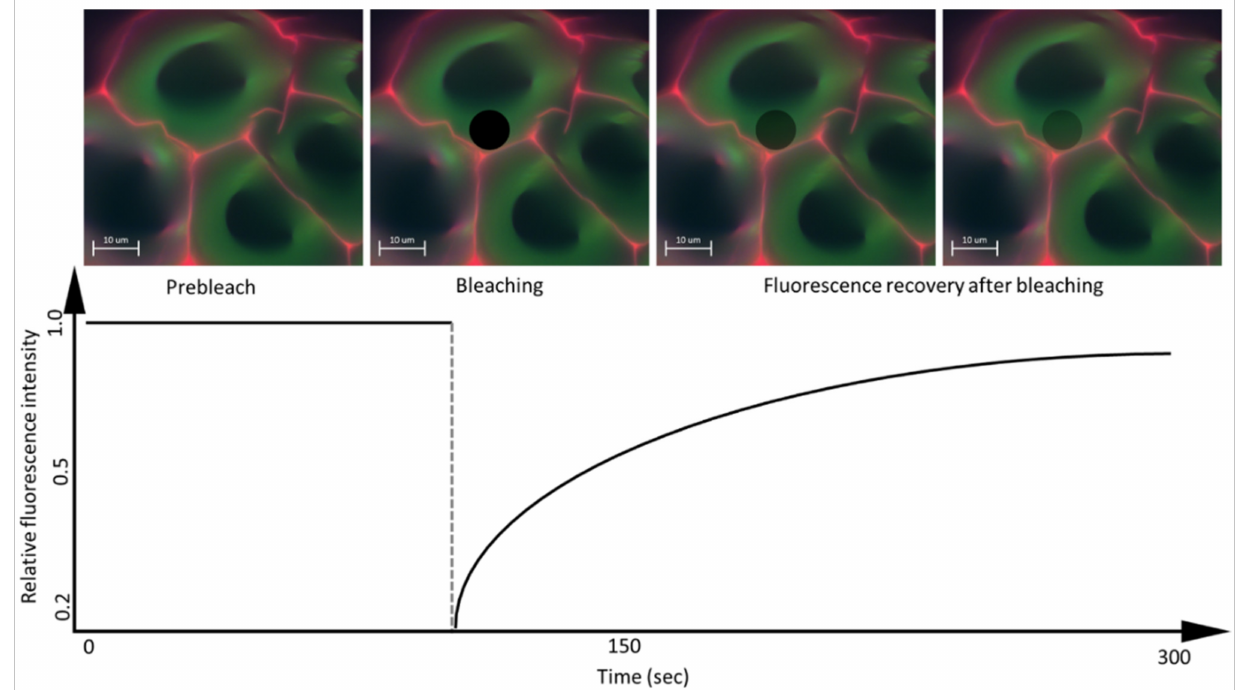
Figure 5. Schematic image of the FRAP method. Image taken from personal file, graphic based in